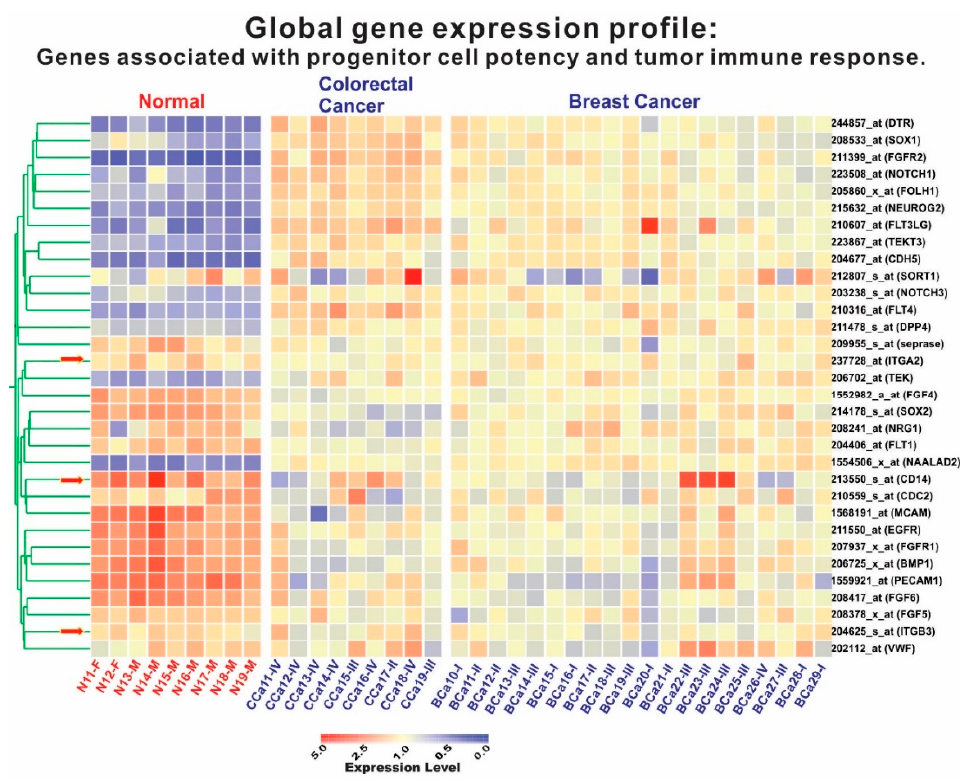
Figure 6. Expression of tumor-progenitor-associated genes in iCTCs isolated by CAM from blood of patients with CRC and breast cancer. Global gene expression profiling of circulating cells isolated by Vita-Cap™ from 9 healthy subjects, 9 CRC patients, and 20 patients with breast cancer. Columns represent catalogues of cell samples analyzed: circulating Normal (N) cells isolated from healthy donors with suffix M for Male and F for Female; CCa are circulating Colorectal Cancer (CCa) cells and BCa are circulating Breast Cancer (BCa) cells with suffixes I–IV being stages of the disease. Colorgram depicts high (red) and low (blue) relative levels of gene expression. Red arrows indicate the three internal control genes that exhibited no difference between normal and cancer cell samples.